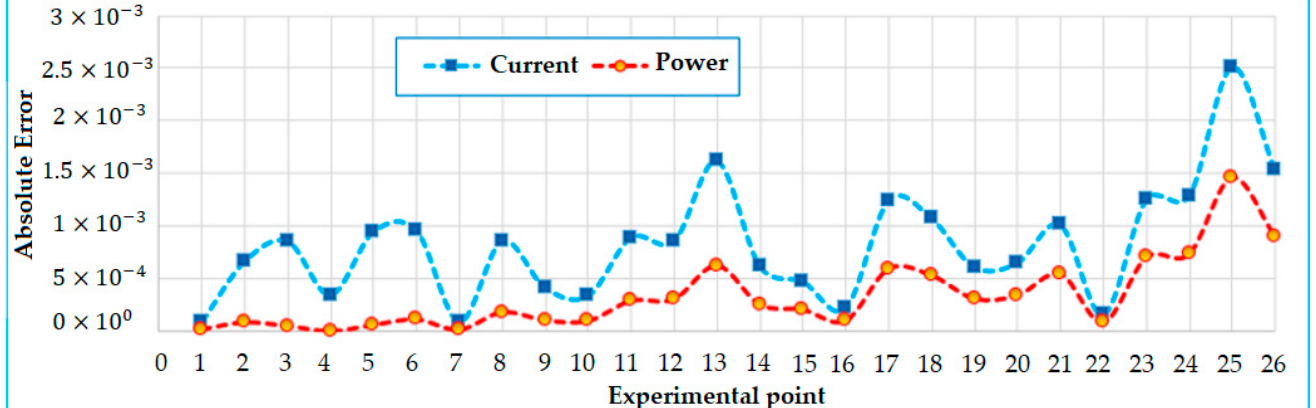
Figure 13. Absolute errors of simulated current and power of the proposed HPO technique for the triple-diode models of RTC France PV cell.